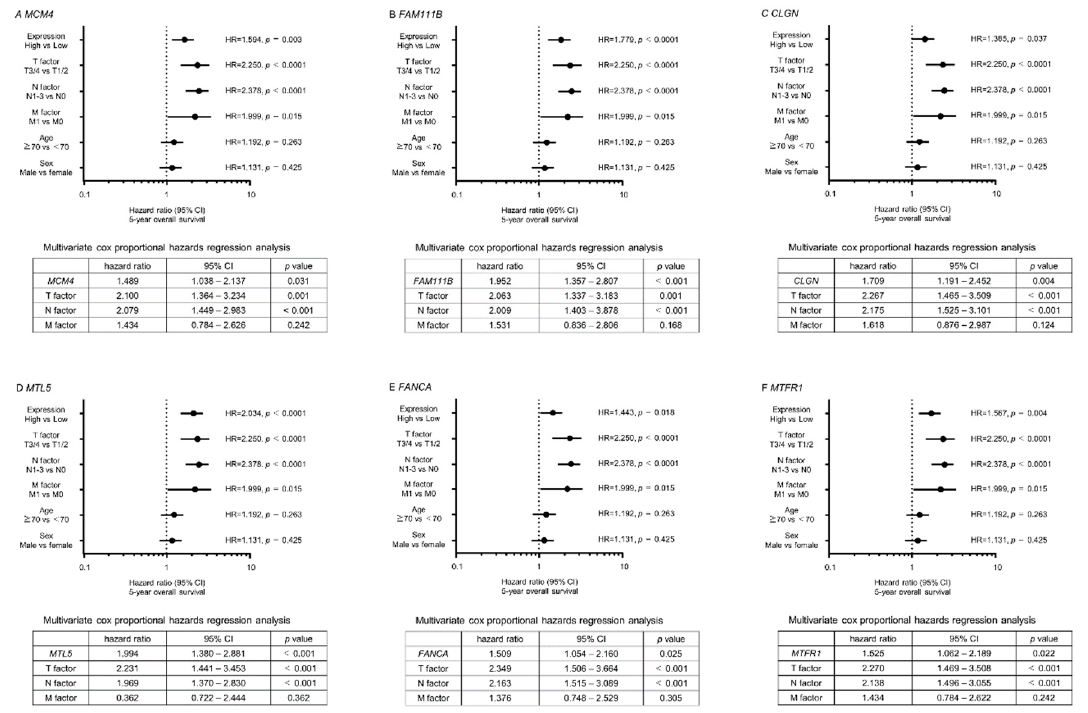
Figure 5. Multivariate analysis of six genes ( MCM4 , FAM111B , CLGN , MTL5 , FANCA , and MTFR1 ). These genes were independent prognostic factors for overall survival.